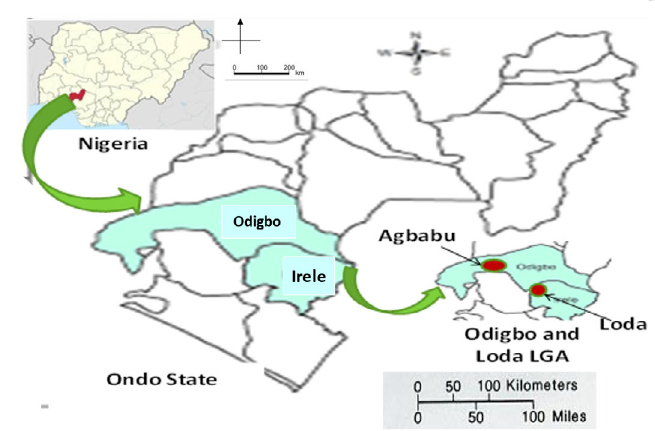
Fig. 5: Penetration in raw bitumen and modifier content Fig. 1 : Geographic location of the study area in Agbabu and Loda in Odigbo and Loda L.G.A., Ondo State, Nigeria